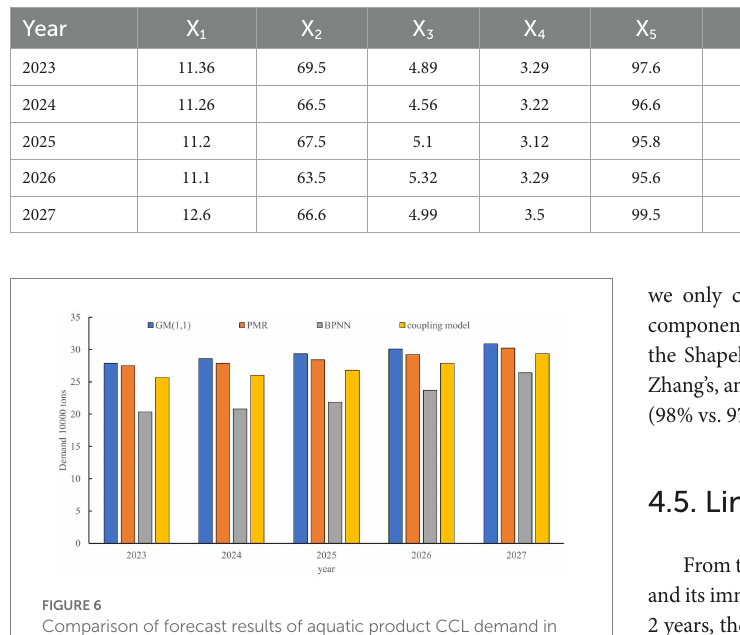
TABLE 7 Predicted values of independent variables 2023–2027.